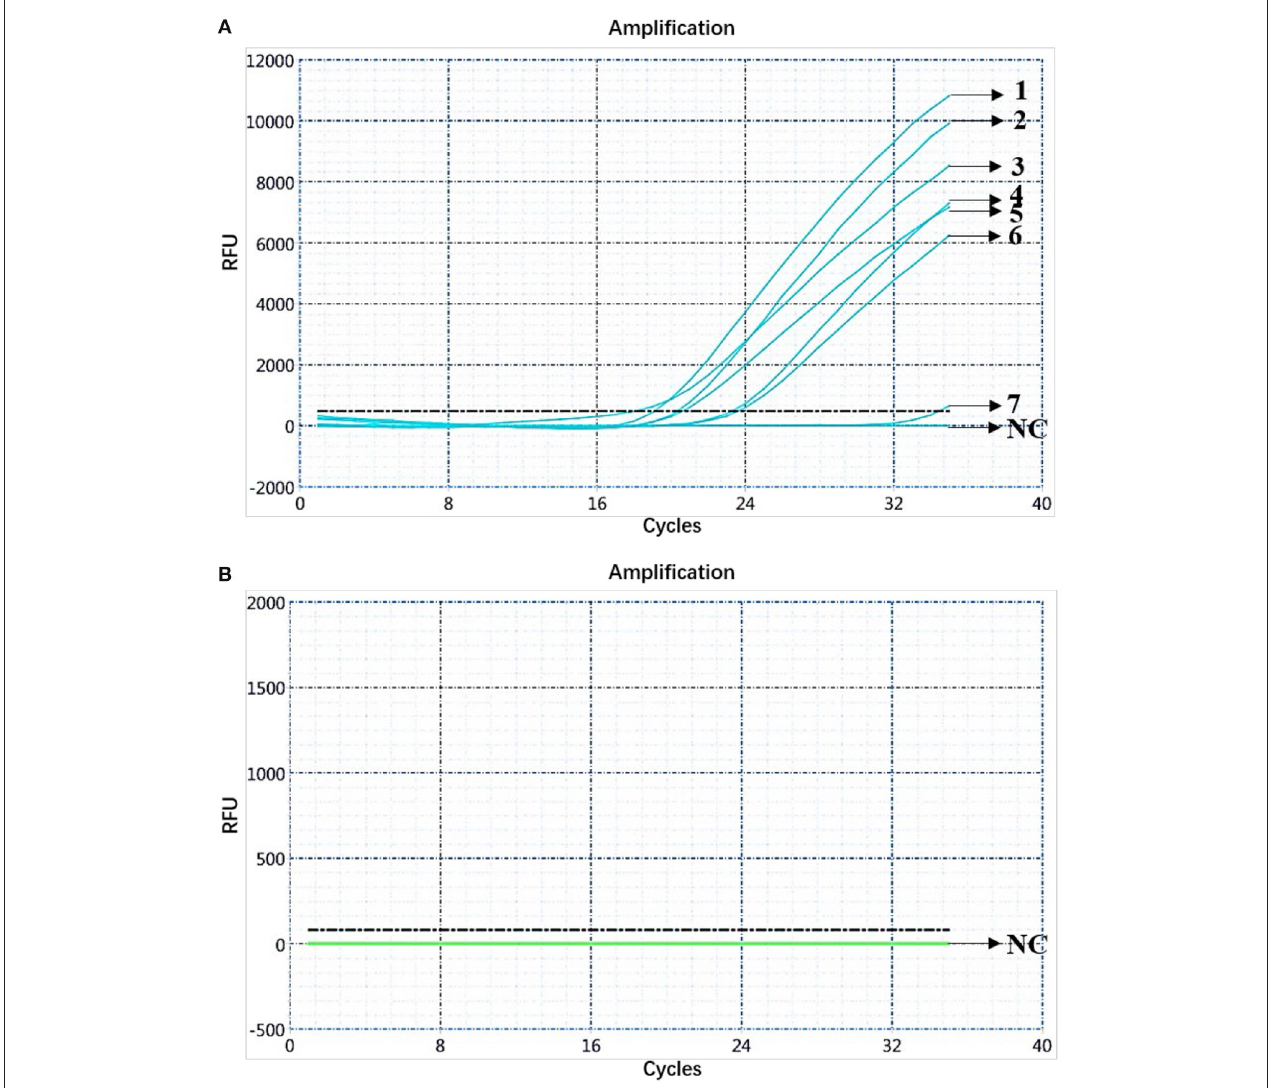
FIGURE 7 | Analysis of clinical samples. (A) Amplification curve for the FAM channel determined through nucleic acid dual fluorescence quantitative PCR of pig clinical samples (284). Pig clinical samples (284) were analyzed using dual real-time PCR; seven samples were ASFV-positive. (B) Amplification curve for the HEX channel determined through nucleic acid dual fluorescence quantitative PCR of pig clinical samples (284) and the remaining 277 samples were